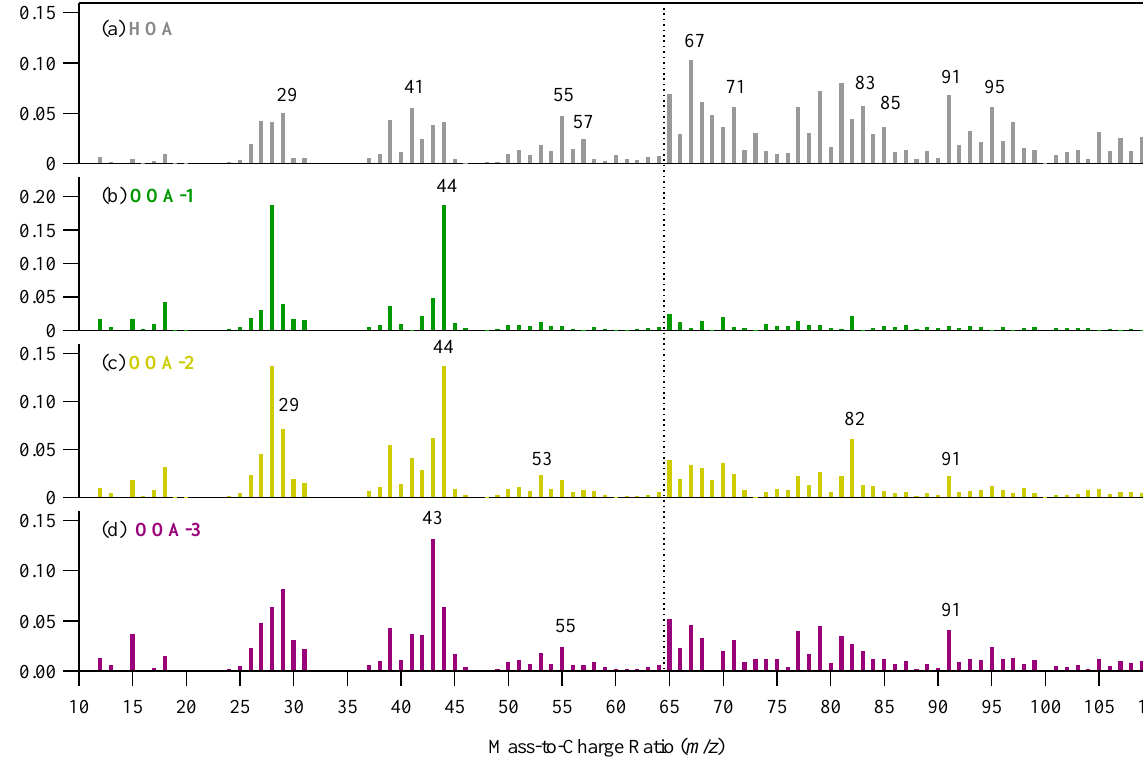
Figure 5. Statistical factors HOA, OOA-1, OOA-2, and OOA-3 identified by PMF analysis. The relative intensities of ions having m/z ≥ 65 were multiplied by